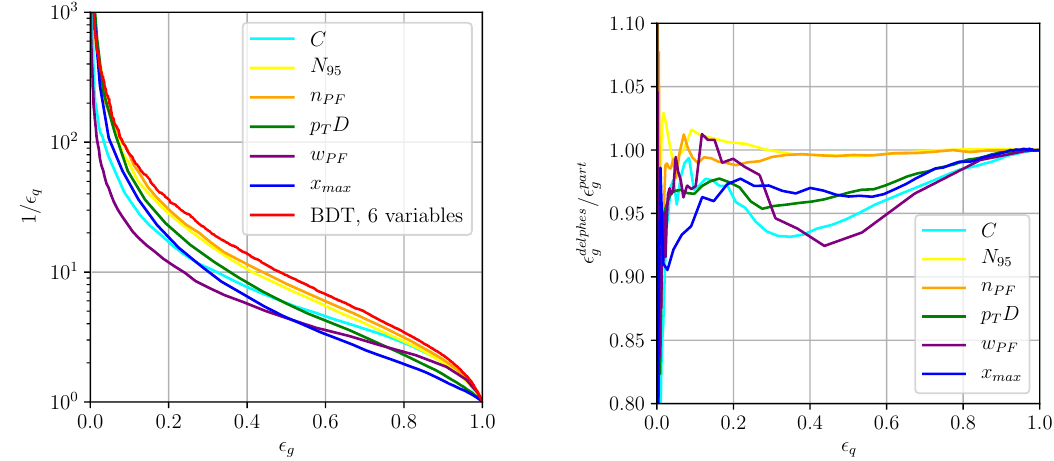
Figure 2: Left: ROC curves for the six quark–gluon observables discussed in the text, including a combination through a BDT, without detector effects. Right: